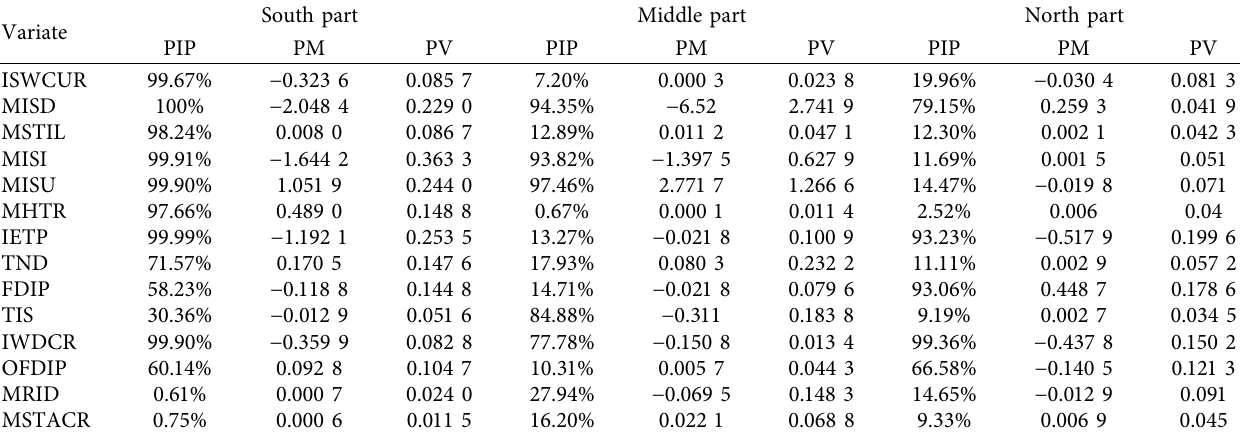
Table 2: BMA regression results of influencing factors of regional marine economic efficiency.